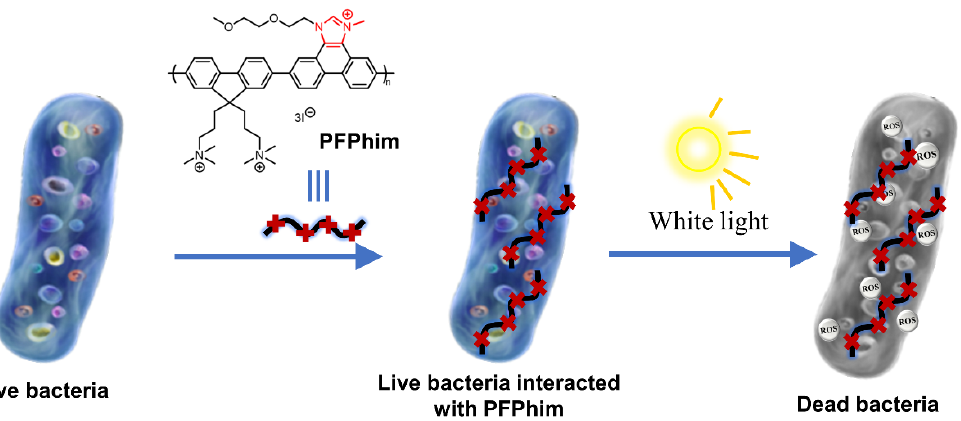
Figure 9. Schematic diagram of PFPhim structure and the inhibition of E. coli via PDT. Reprinted with permission from Ref. [50]. Copyright 2019, Elsevier B.V.